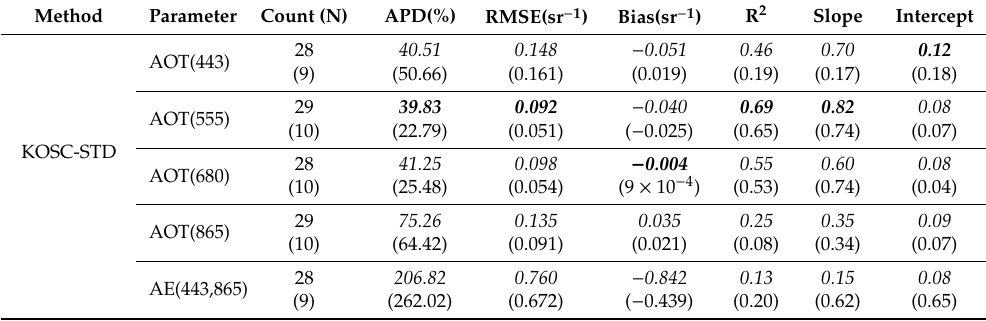
Table 7. Validation statistics for the KOSC-STD method of GOCI-derived AOT(443), AOT(555), AOT(680), AOT(865), and AE(443,865) at 02:16, 03:16, and 04:16 UTC: APD (%), RMSE (sr − 1 ), Bias (sr − 1 ), R 2 (dimensionless), Slope (dimensionless), Intercept (dimensionless). The presentation style is the same as described in Table